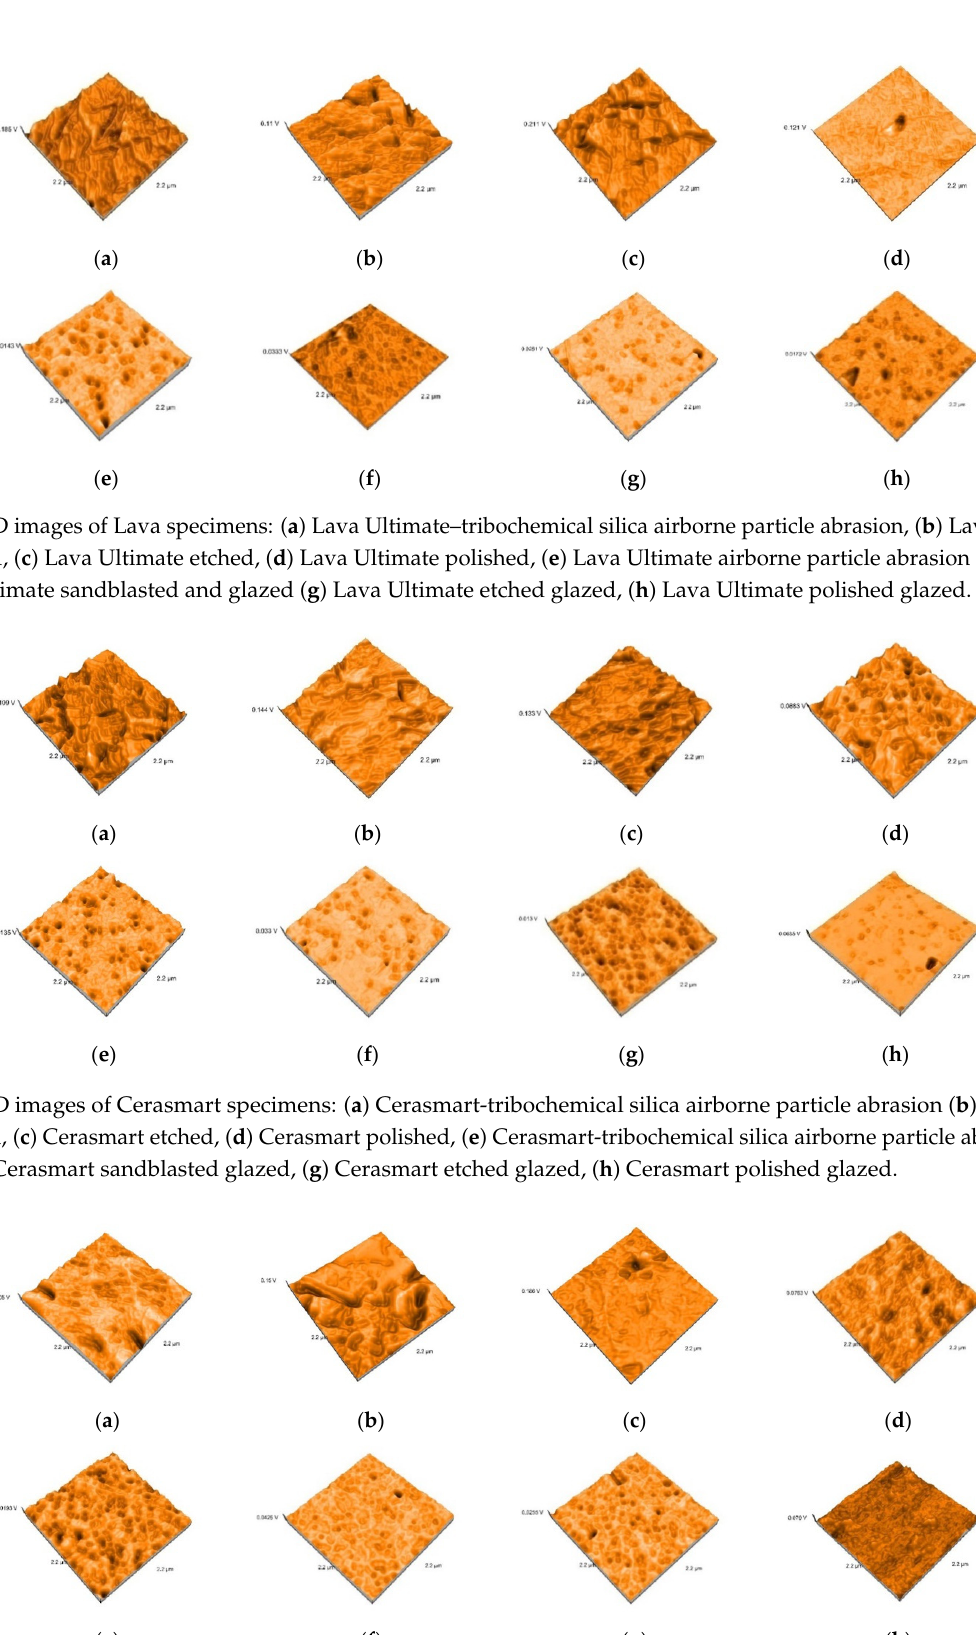
Figure 3. 3D images of Vita Enamic specimens: ( a ) Enamic-tribochemical silica airborne particle abrasion, ( b ) Enamic- sandblasted, ( c ) Enamic-etched, ( d ) Enamic-polished, ( e ) Enamic tribochemical silica airborne particle abrasionand glazed +, ( f ) Enamic–sandblasted and glazed ( g ) Enamic etched and glazed, ( h ) Enamic polished and glazed.